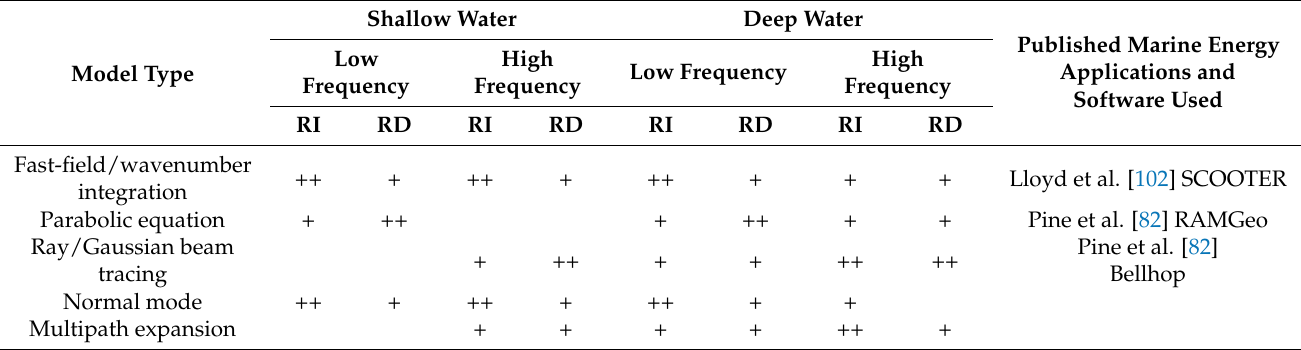
Table 2. Domains of frequently used farfield propagation models adapted from Etter [100], marine energy applications, and software used. ++ indicates that the model approach is applicable and practical in that domain; + indicates limitations in accuracy or execution speed; and blank cells indicate the model is not applicable. Low frequency <500 Hz, high frequencies >500 Hz. RI = range-independent (environment does not change with horizontal distance from source); RD = range-dependent (horizontally heterogeneous